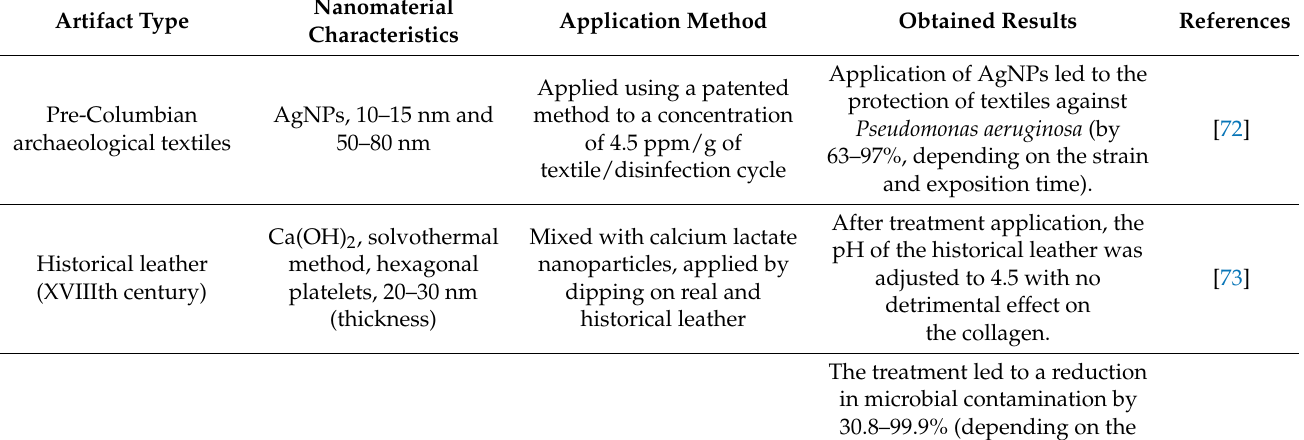
Table 3. Application of inorganic nanomaterials for the treatment of other types of cultural heritage of an organic nature (references presented in chronological